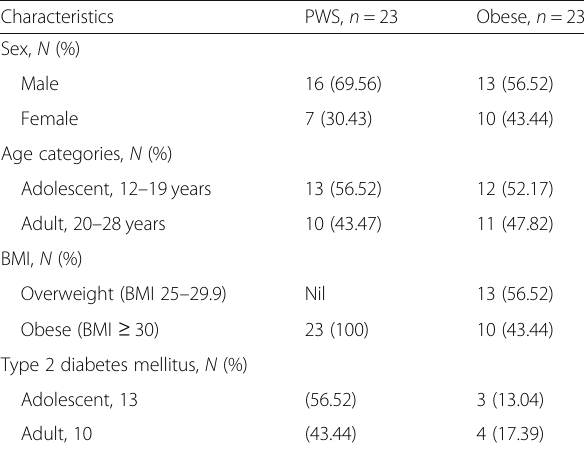
Table 1 General characteristic of the study population in PWS and obese